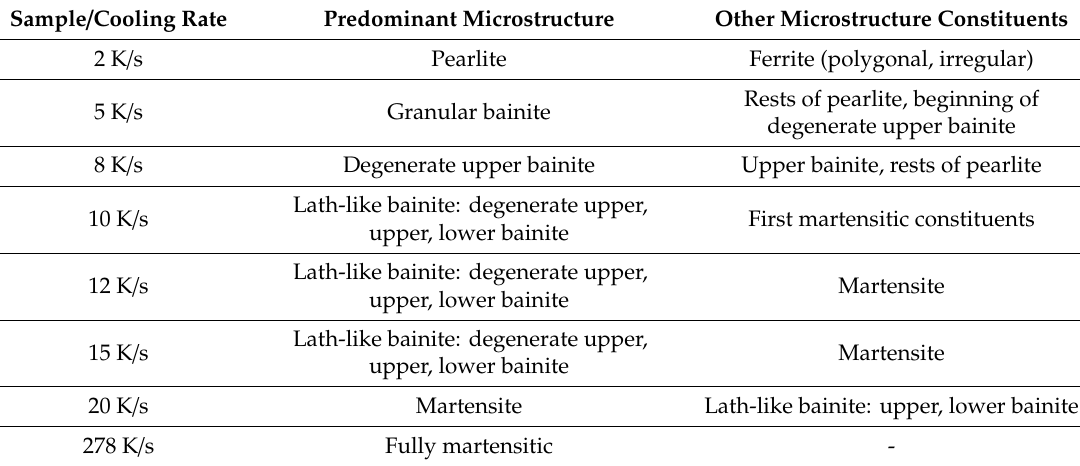
Figure 5. Continuous cooling diagram showing di ff erent cooling rates after austenitization at 1000 ◦ C, phase transitions of ferrite, pearlite, bainite, and martensite. Additionally, regions where di ff erent microstructures predominantly formed are shown. Also, measured hardness values (HV1) for each cooling rate are added. Table 2. List of microstructures found in the produced samples.